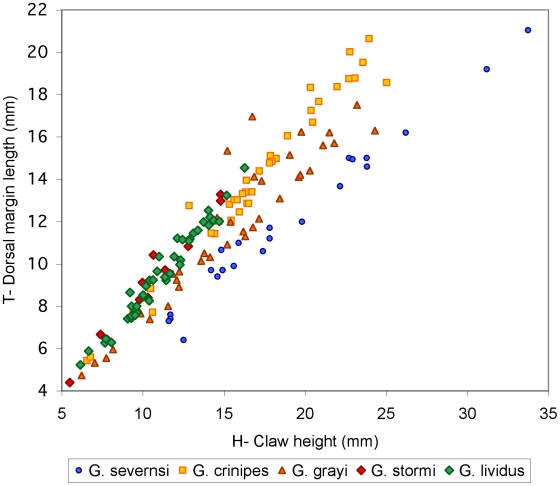
Claw height (H) vs. length of dorsal claw margin (T) in mm.